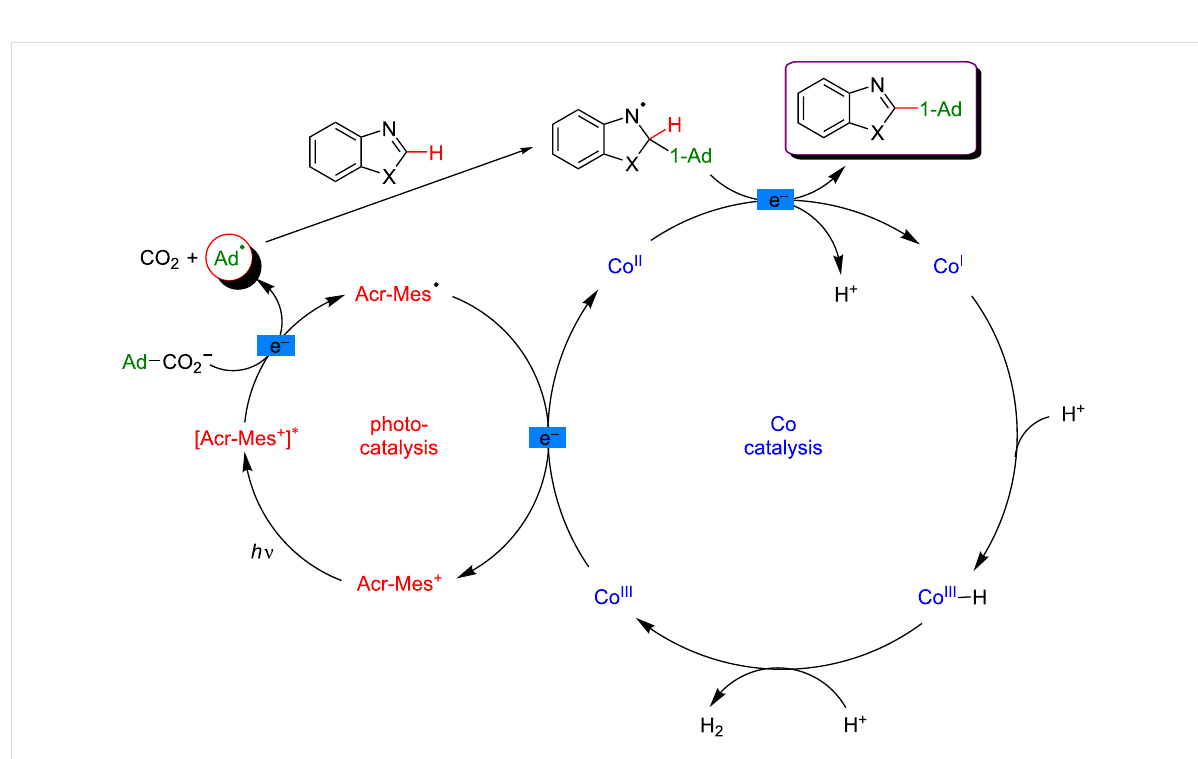
Figure 49: Proposed mechanism for the C–H adamantylation of azoles via dual